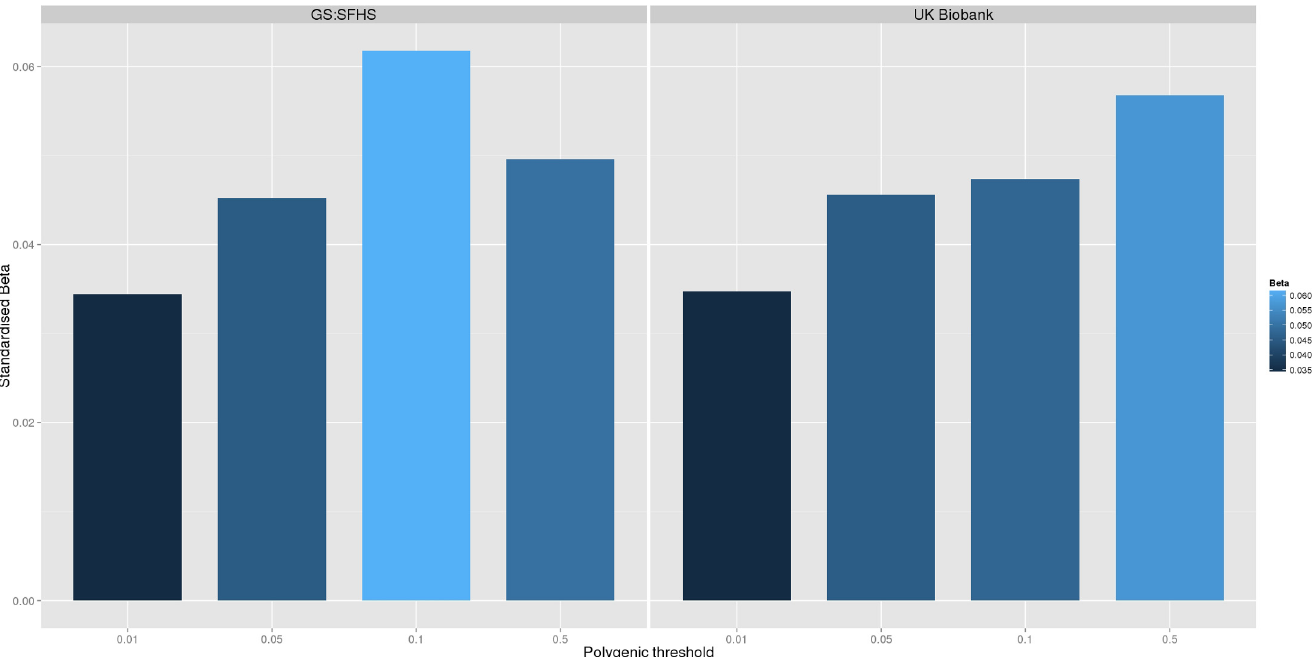
Fig 1. The association between Pfizer-23andMe – derived polygenic risk profiles scores for pain on chronic pain phenotypes in GS:SFHS (left panel) and UK Biobank (right panel). This figure shows the association between polygenic risk scores for pain (derived from Pfizer-23andMe data) and chronic pain in GS:SFHS (left panel) and UK Biobank (right panel). Vertical y -axis represents the effect size as a standardised beta; horizontal axis represents the four alternative p -value thresholds used for the generation of polygenic scores in the discovery GWAS studies.